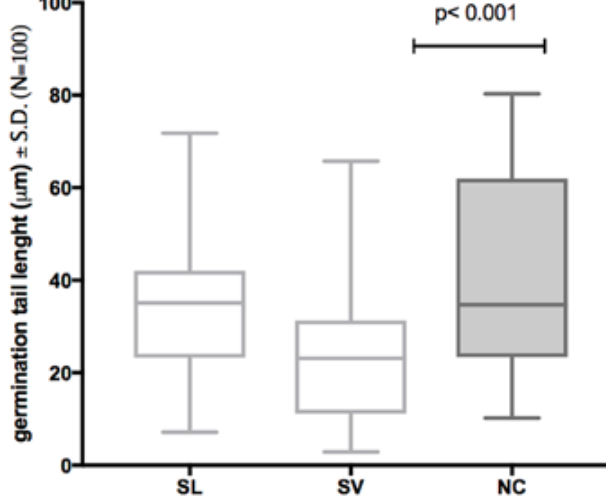
FIGURE 2 - The comparison of tail length of germinated C. albicans ATCC 90028 cells inhibited by Sternbergia spp. Extracts. Legend: SL= Sternbergia lutea; SV= Sternbergia vernalis extract; NC=negative control (non-treated cells). All results were obtained with concentration of 90 µ g/mL